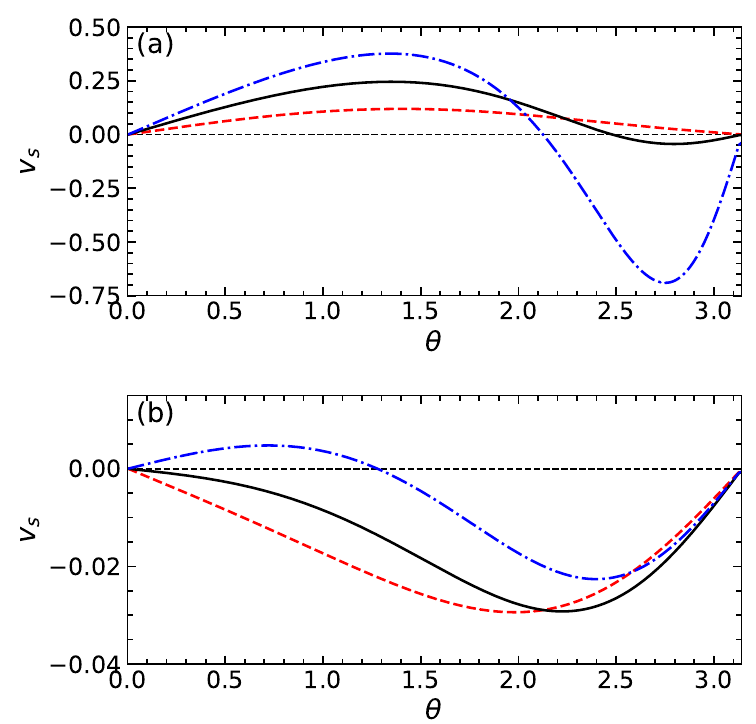
Figure 3. An apparent slip velocity as a function of θ for swimmers of the first ( a ) and second ( b ) type calculated using φ s = − 0.5 and Da = 0.5 (dashed curve), 1 (solid curve) 1.5 (dash-dotted